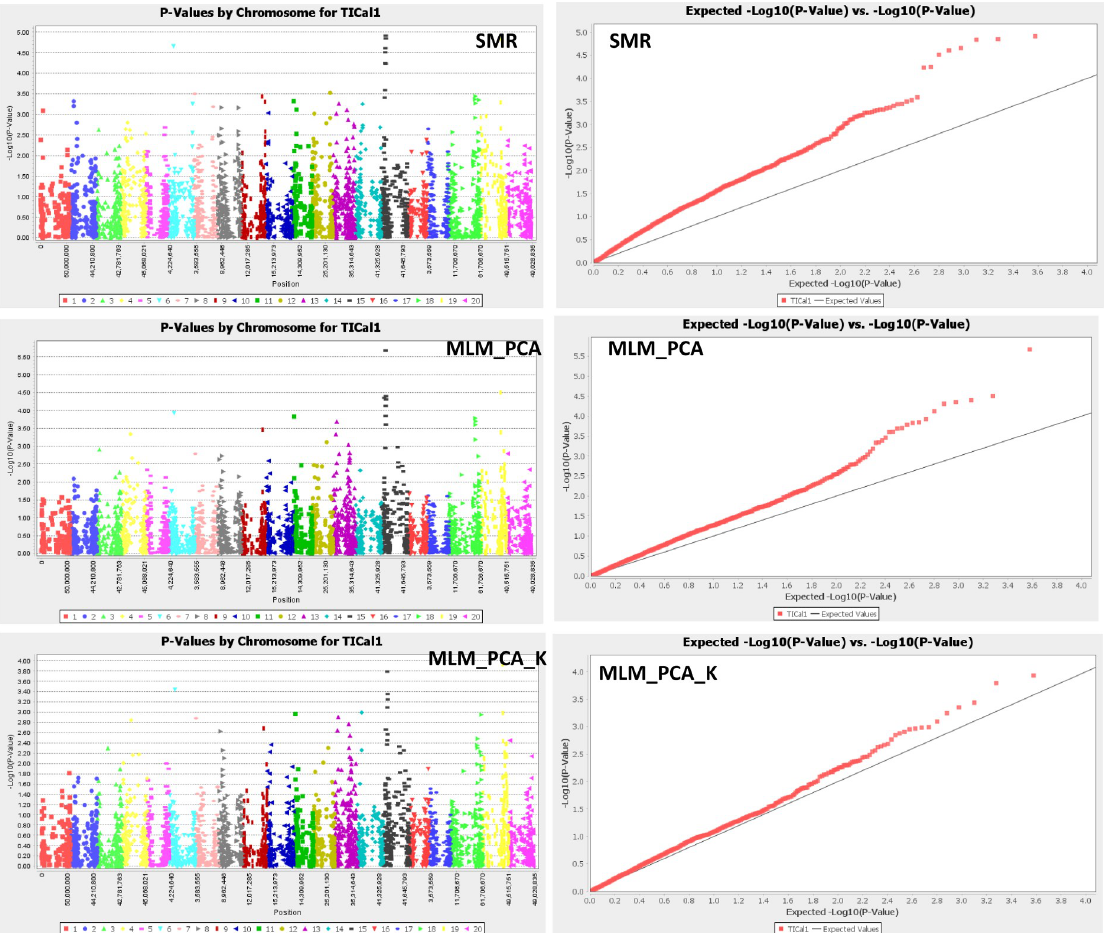
Fig 2. Manhattan plots and QQ-plots for tolerance indexes based on biomass reduction under SCN infestation. The x-axis of each Manhattan plot represented the chromosome number, whereas the y-axis denoted the LOD (-log10(p-value)). Color coding on the Manhattan plot is chromosome-wise. The x-axis of each QQ-plot represented the expected -log10(p-value), whereas the y-axis displayed the observed -log10(p-value). A : Manhattan plot and QQ-plot resulted from the single marker regression model (SMR). B : Manhattan plot and QQ-plot obtained using the generalized linear model (GLM(PCA)). C : Manhattan plot and QQ-plot generated by the mixed liner model